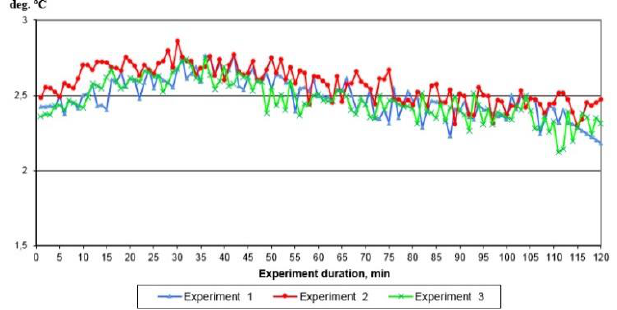
Figure 7. The temperature difference of the working fluid as it passes through the flow part of the HDH in the preset pressure at the 80% pump